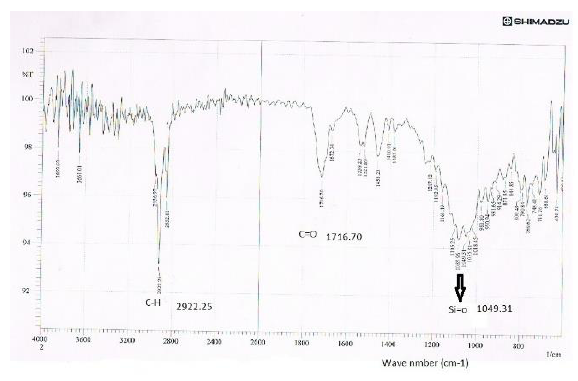
Figure 3: FTIR spectrum of VLCR/ SiO nanofiller.